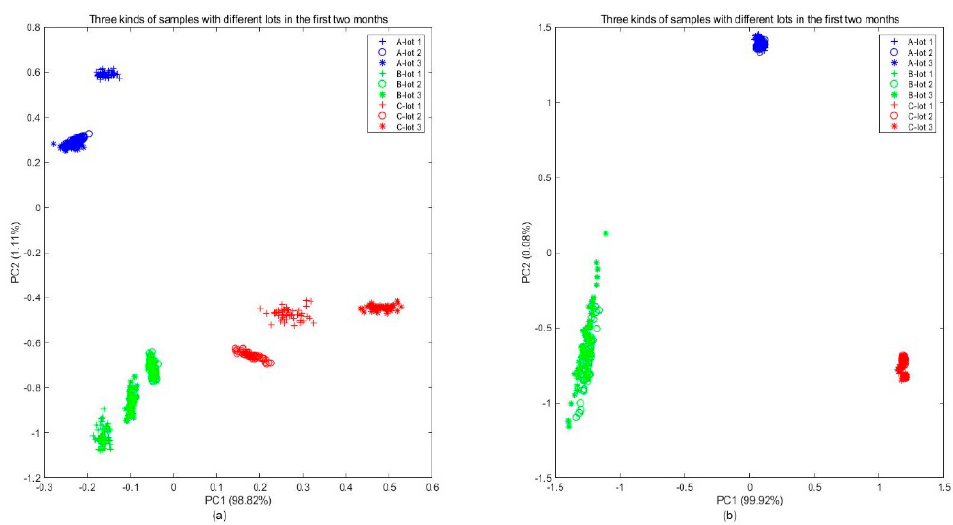
Figure 8. Examples of distribution varying across different kinds and lots: ( a ) original measurements and ( b ) new features that are independent of lots extracted from original measurements by the MICF.